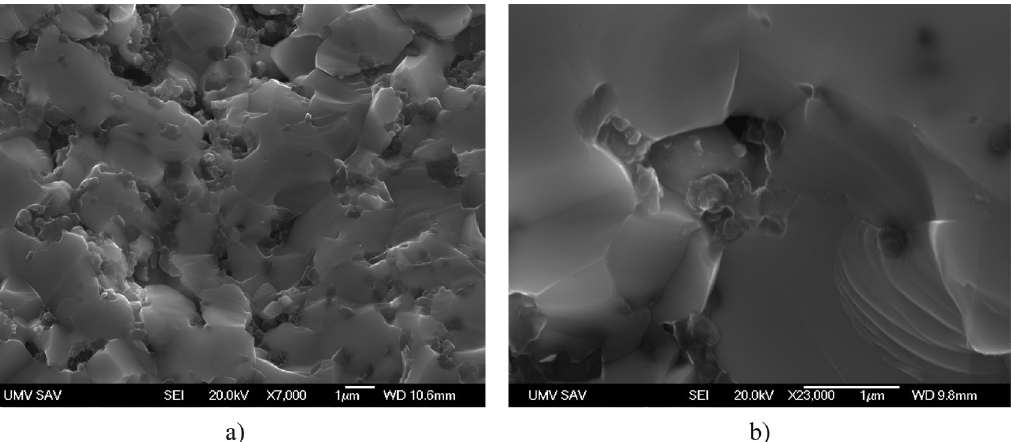
Fig. 6: Fracture of the composite MoSi 2 with 10% SiC particles broken at room temperature after finishing creep: a) transcrystalline brittle fracture and b) detail of the grain boundaries with clusters of the SiC particles